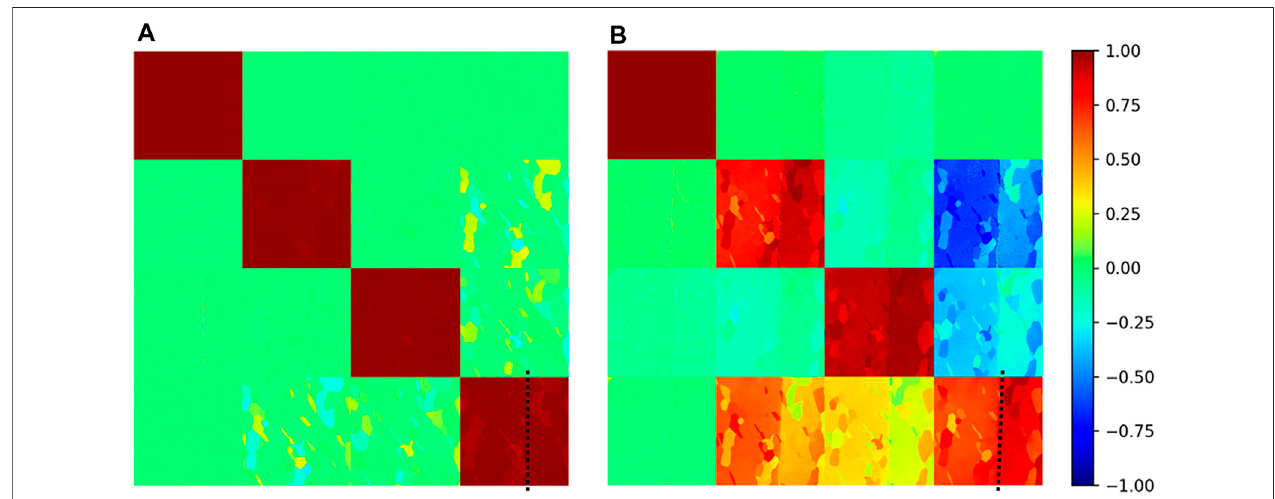
FIGURE 3 | Experimentally measured Mueller matrix of the PAA sample with normal incidence (A) and 32 ° tilting angle (B) . The black dotted line separates the regions with different pore sizes.